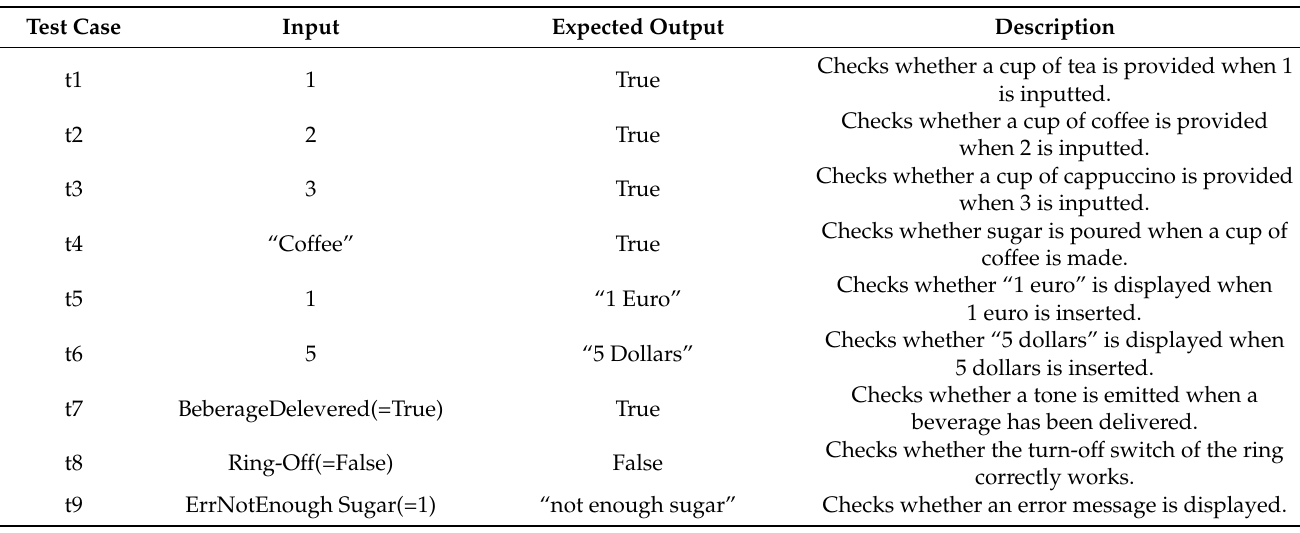
Table 2. Test cases for SPL V0 .